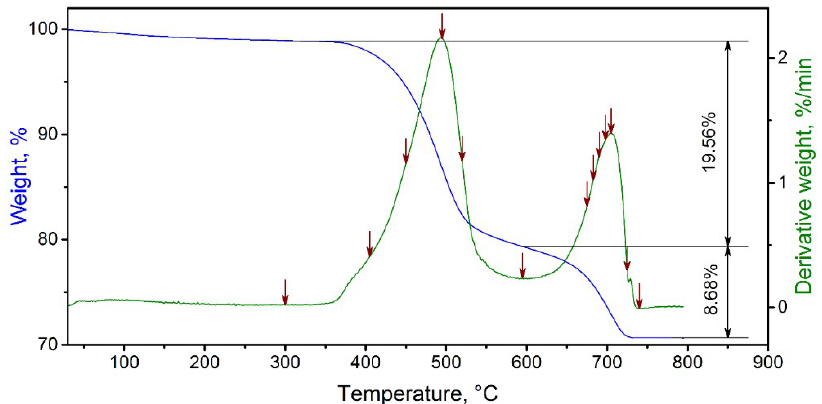
Figure 1. Thermogravimetric results for the oxide precursor in 100 mL/min 20% N 2 /H 2 flow. Heating rate of 10 °C/min. Arrows indicate temperatures at which the process was interrupted in order to study chemical and morphological transformations.